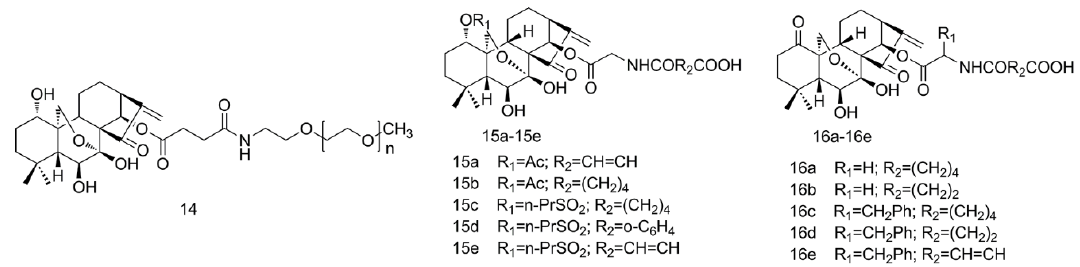
Figure 4. PEGylation and esterification of ORI.